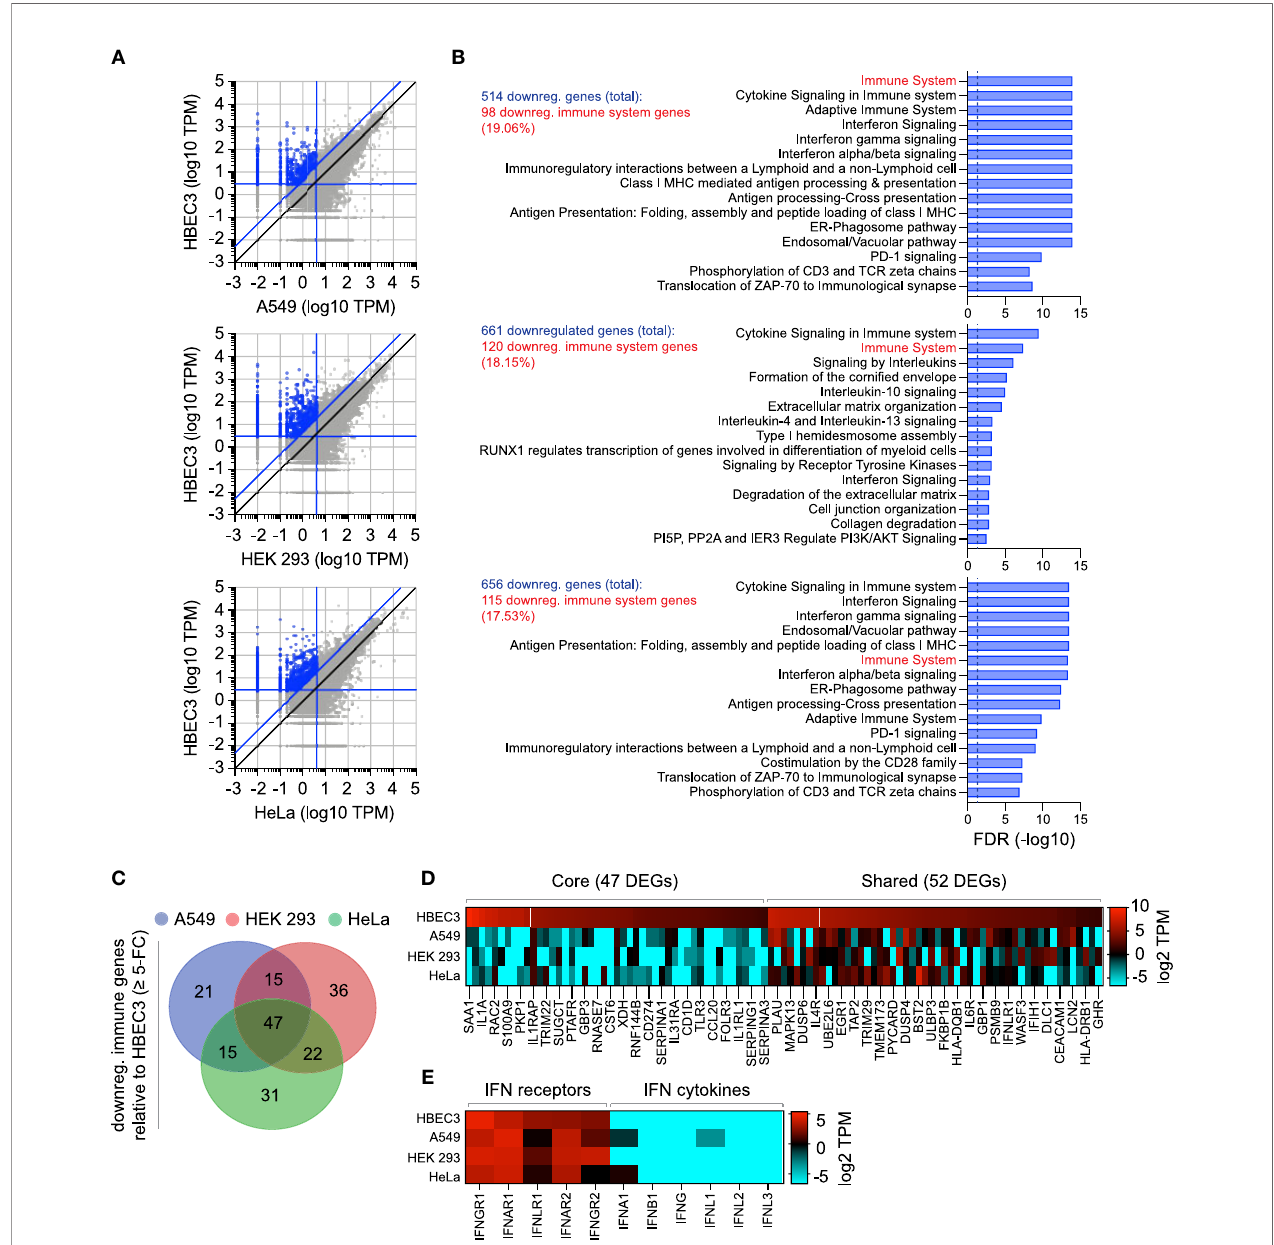
FIGURE 6 | Laboratory-adapted cell lines have downregulated levels of constitutive immune gene expression relative to human bronchial epithelial cells. (A) Scatter plots showing differentially expressed gene (DEG) transcripts identi fi ed to be downregulated (blue circles; ≥ 5-fold change, diagonal blue line) in A549, HEK 293, and HeLa (top, middle, and bottom panels, respectively; vertical blue line, ≤ 4 TPM) relative to HBEC3 cells (horizontal blue line, ≥ 3 TPM). Values shown in Supplemental Table S3A . (B) Reactome pathway analysis of mapped DEGs (identi fi ed in A ). The top 15 most signi fi cantly enriched pathways plotted (-log10 FDR shown; Supplemental Tables S3B-D ). Dotted line, threshold of signi fi cance (-log10 FDR of 0.05). The number of downregulated DEGs identi fi ed and immune system percentile shown (blue and red text, respectively). (C) Venn diagram showing the number of unique and shared immune system DEGs (identi fi ed in B ; Supplemental Table S3E ) for each paired condition analyzed. (D) Heat map showing the expression pro fi le (log2 TPM) of conserved (core, 47 genes) or shared (52 genes) immune system DEGs (as in C ). Every second gene labelled. Values shown in Supplemental Table S3F . (E) Heat map showing IFN-related receptor and cytokine expression pro fi les (log2 TPM) in A549, HEK 293, HeLa, and HBEC3 cells. Values shown in Supplemental Table S3G